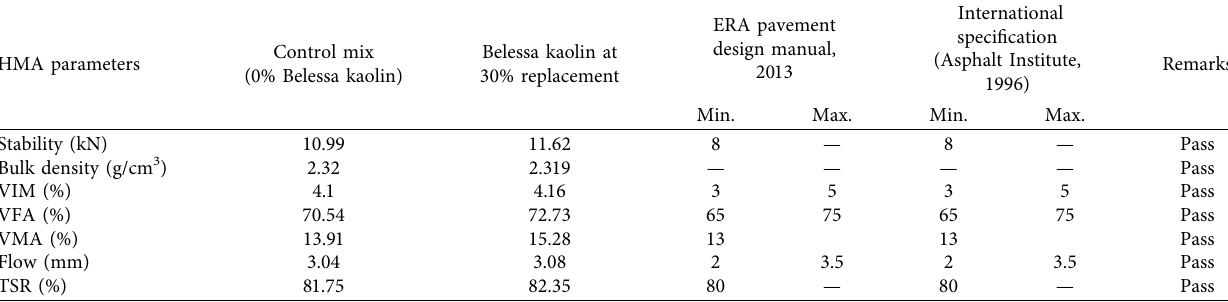
Table 11: Comparison of optimum replacement proportion of Belessa kaolin with